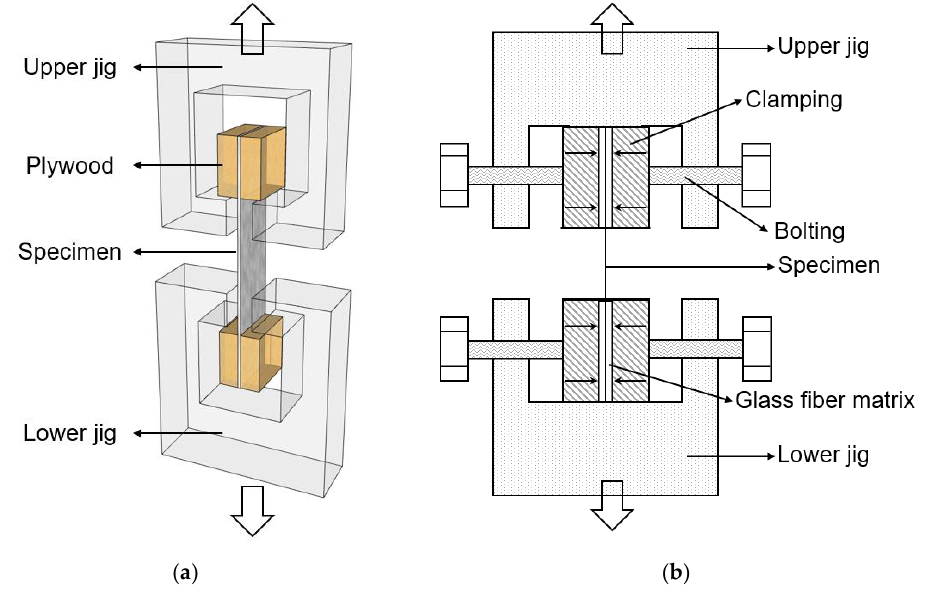
Figure 5. Schematic illustration of the preparations of the experimental setup: ( a ) conventional method and ( b ) proposed method.